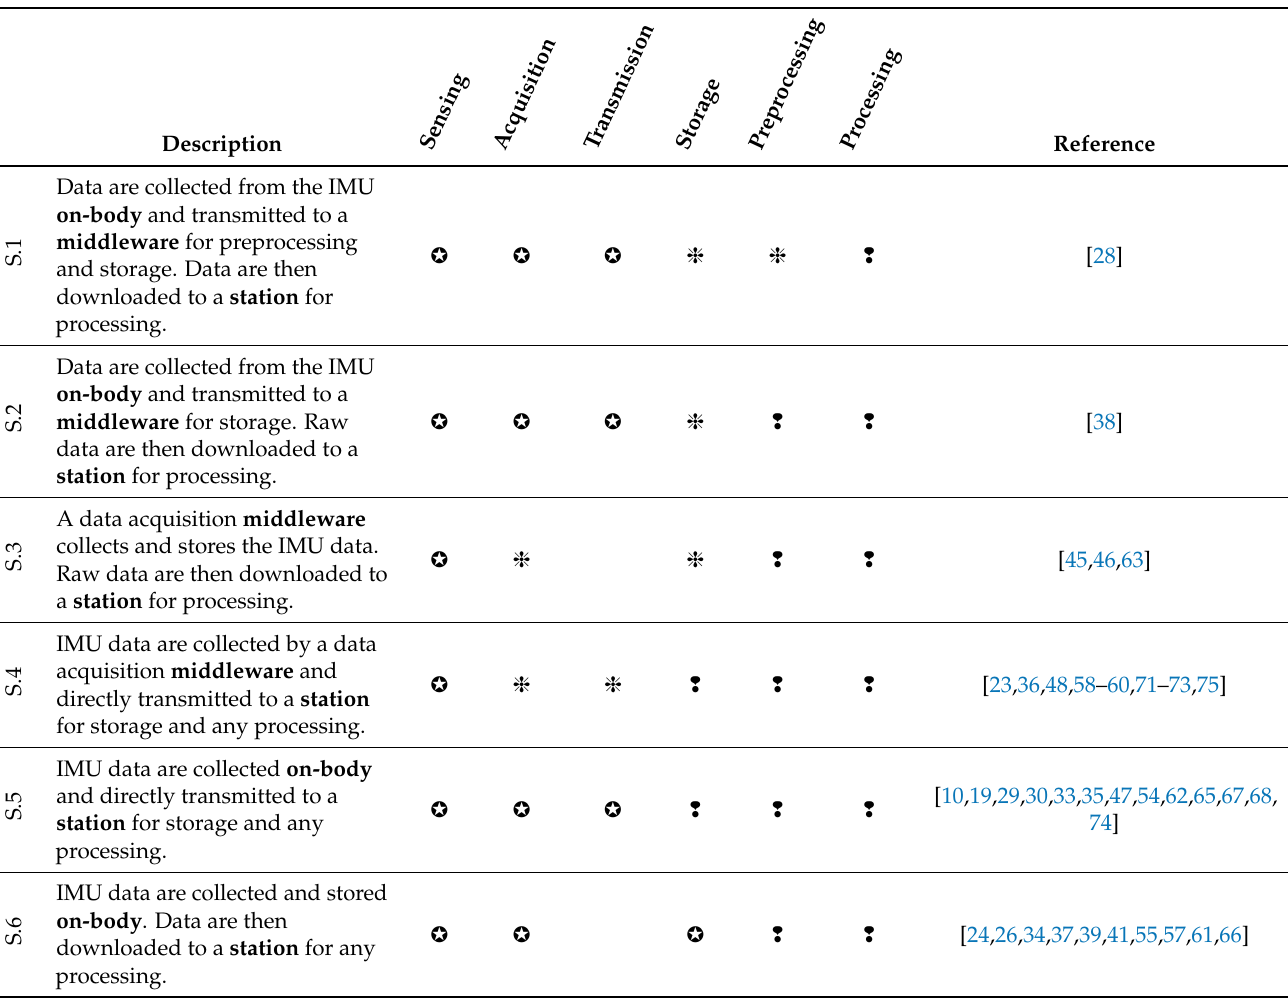
Table 5. Processing units used for different stages in the referenced studies. (cid:74) Shows that the on-body hardware is responsible for the stage, (cid:104) indicates that the stage is handled by a middleware and (cid:162) shows that an off-body processing station handles the